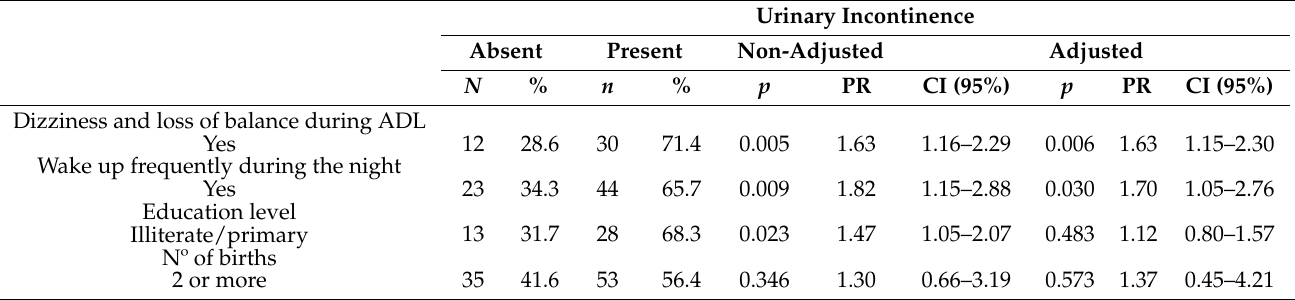
Table 3. Non-adjusted and adjusted prevalence and prevalence ratios for UI in older women who practice physical activities. Natal, Brazil,